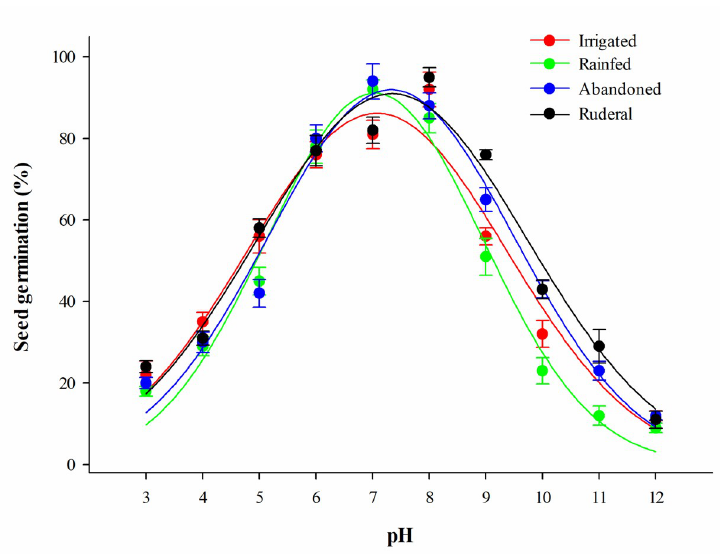
Fig 6. The influence of different pH levels on seed germination of Conyza stricta Willd. The vertical bars present standard errors of means (n = 10).